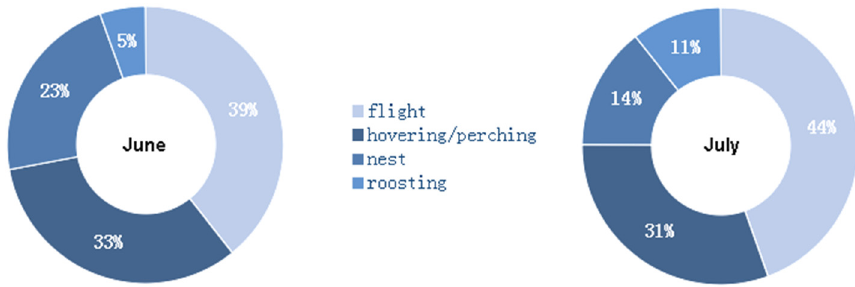
Figure 3. Ethograms of the tracked red-footed falcons for (left) June and (right) July. Both females (constrained sample vs. expected chi-squared test = 1405.4; d.f. = 3; p < 0.01) and males (constrained sample vs. expected chi-squared test = 2538.4; d.f. = 3; p < 0.01) diverged from the perfect balance among the four activities (Figure 4). While roost- ing was almost null in females, this activity occupied 11% of the time in male red-footed falcons. By contrast, females spent 7% more of the time than males did for hovering and perching. The male vs. female activity budgets were significantly different (unconstrained Sample 1 vs. Sample 2 chi-squared test = 406.34; d.f. = 4; p < 0.01).